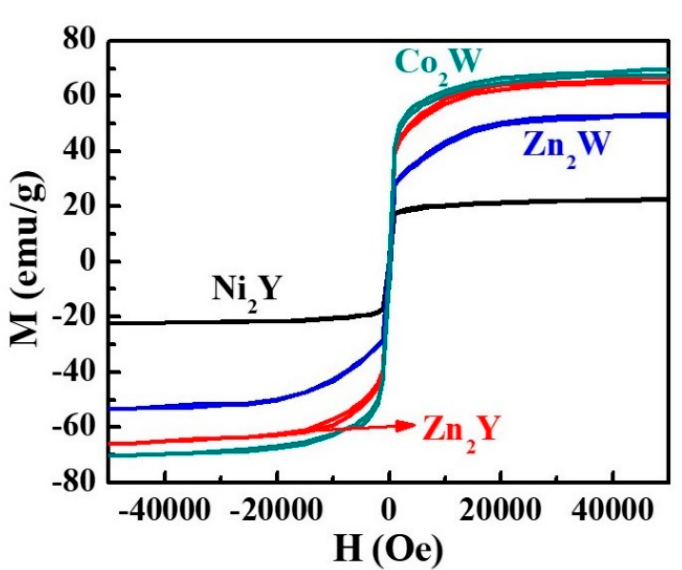
Figure 3. Room temperature magnetization versus H data for annealed fibers of Ni 2 Y, Zn 2 Y, Zn 2 W, and Co 2 W.